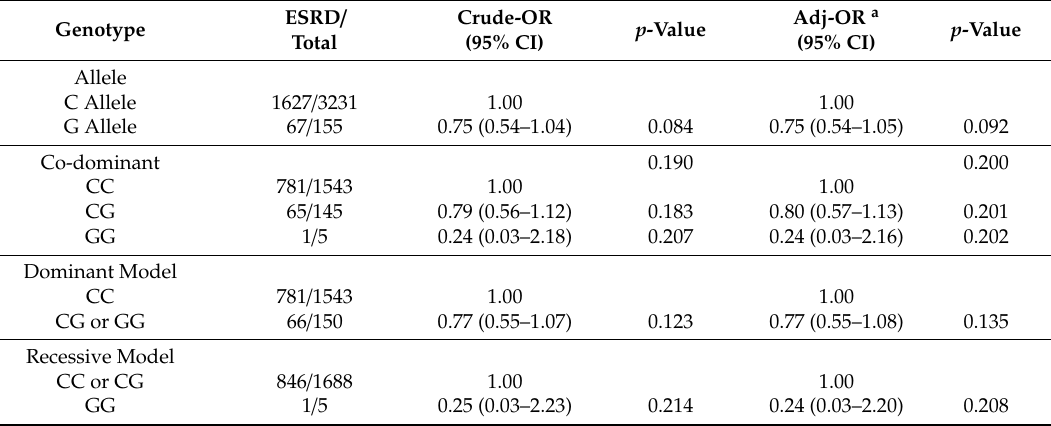
Table 4. Correlation between PPARG Pro12Ala gene polymorphisms and the risk of